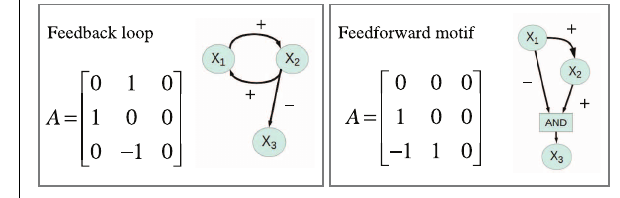
FIGURE 4 | Connectivity matrices and signed directed graphs. Connectivity matrix A and the corresponding signed directed graph for two of the 1881 systems in the simulation study. The left panel depicts the connectivity matrix and the signed digraph of a system with a positive feedback loop between X 1 and X 2 while the right panel shows a system with incoherent feedforward from X 1 to X 3